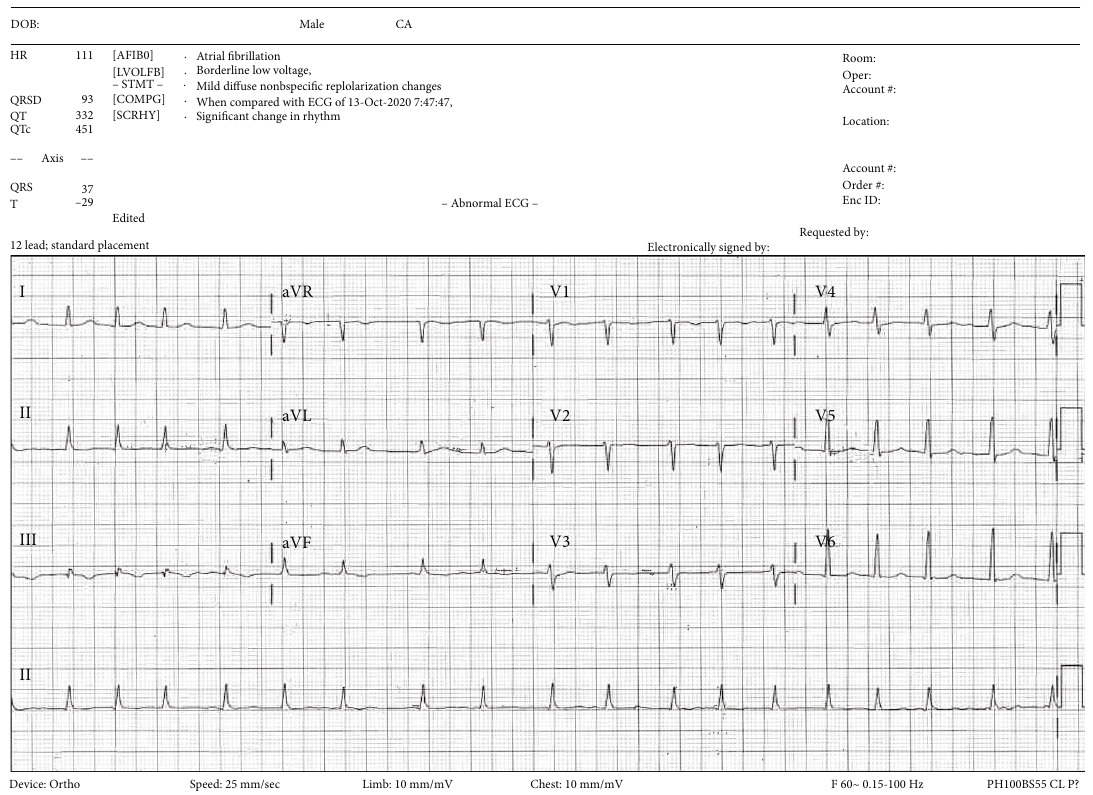
Figure 1: First electrocardiogram revealing atrial fi brillation without any ST-TW